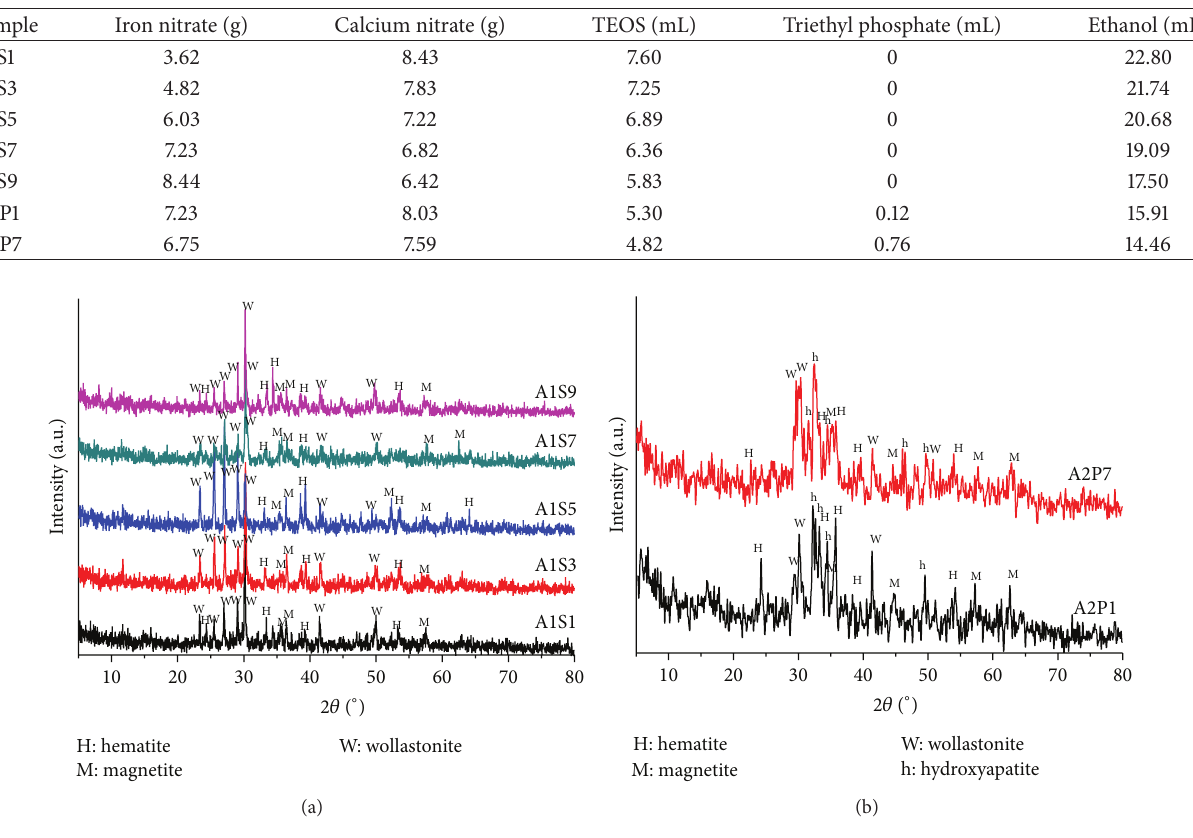
Figure 2: Room temperature XRD patterns of glass ceramic samples.